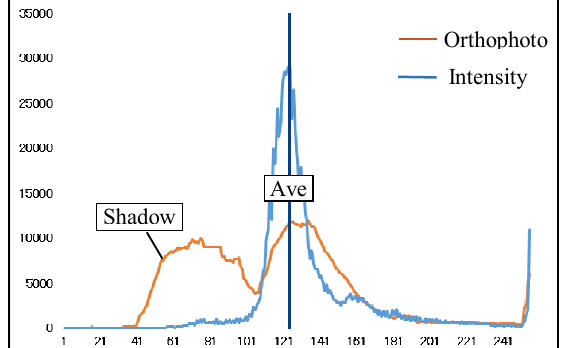
Figure 11. Intensity chart (8-bit) and orthophoto brightness